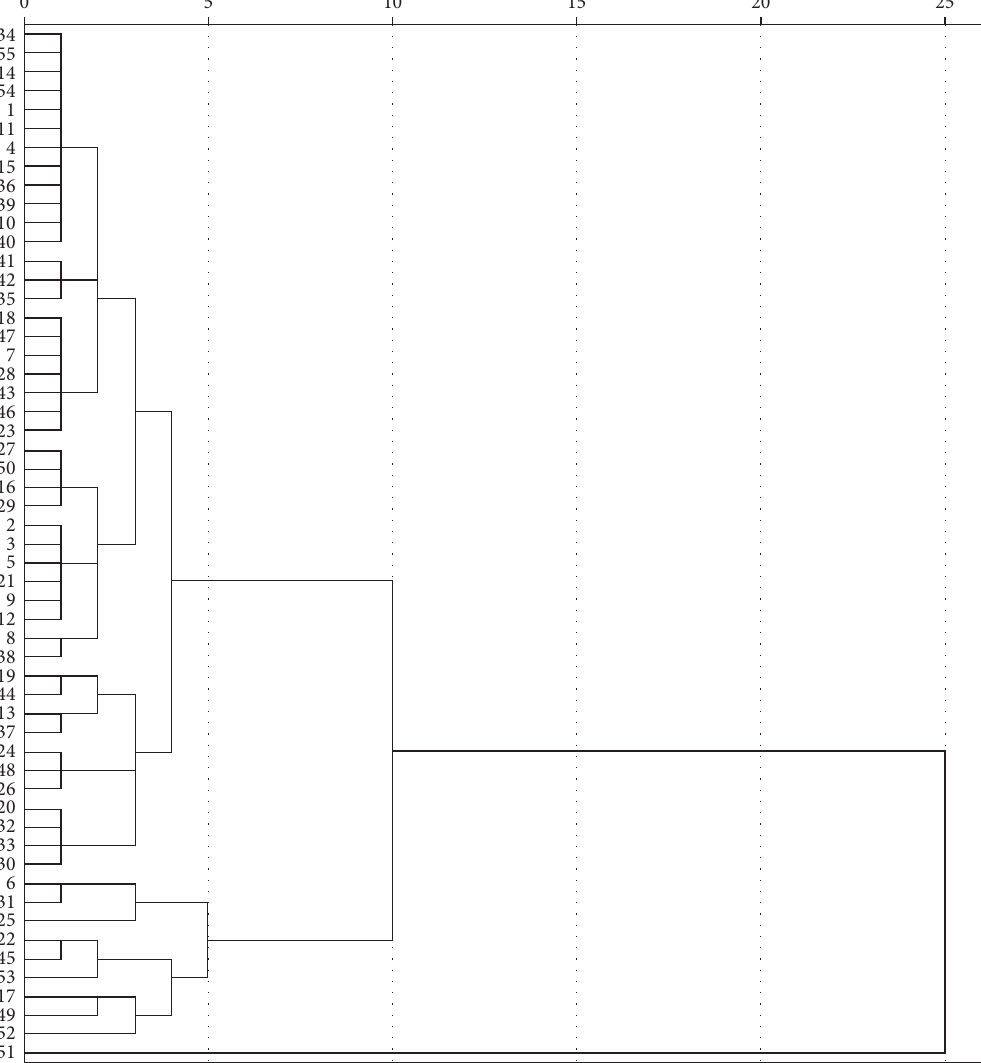
Figure 5: The cluster analysis tree of 55 batches of commercial SR (the indicator is the total content of six chromone